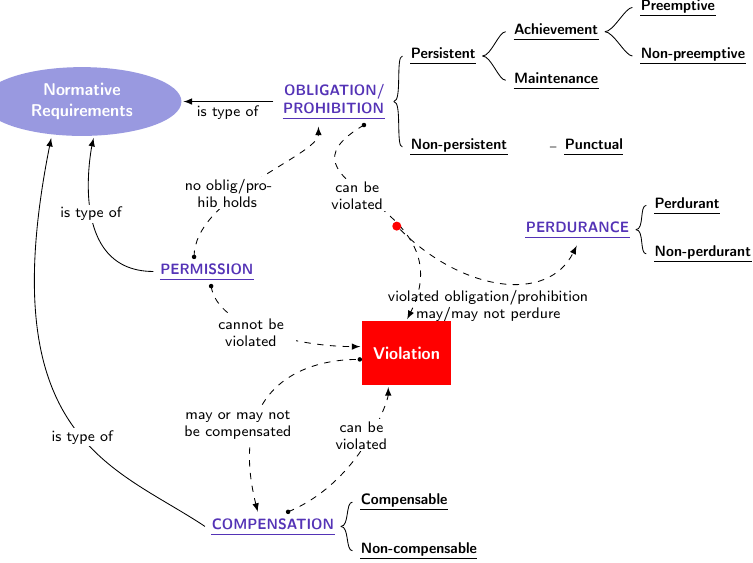
Figure 9. Classification of normative requirements (adopted from